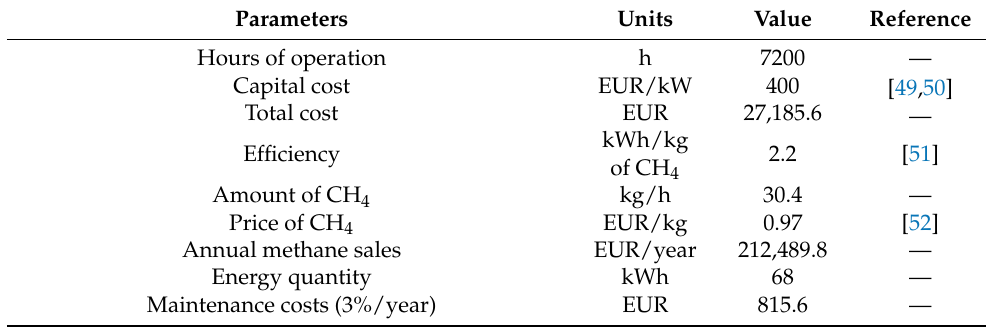
Table 5. Initial assumptions for the methanation unit.